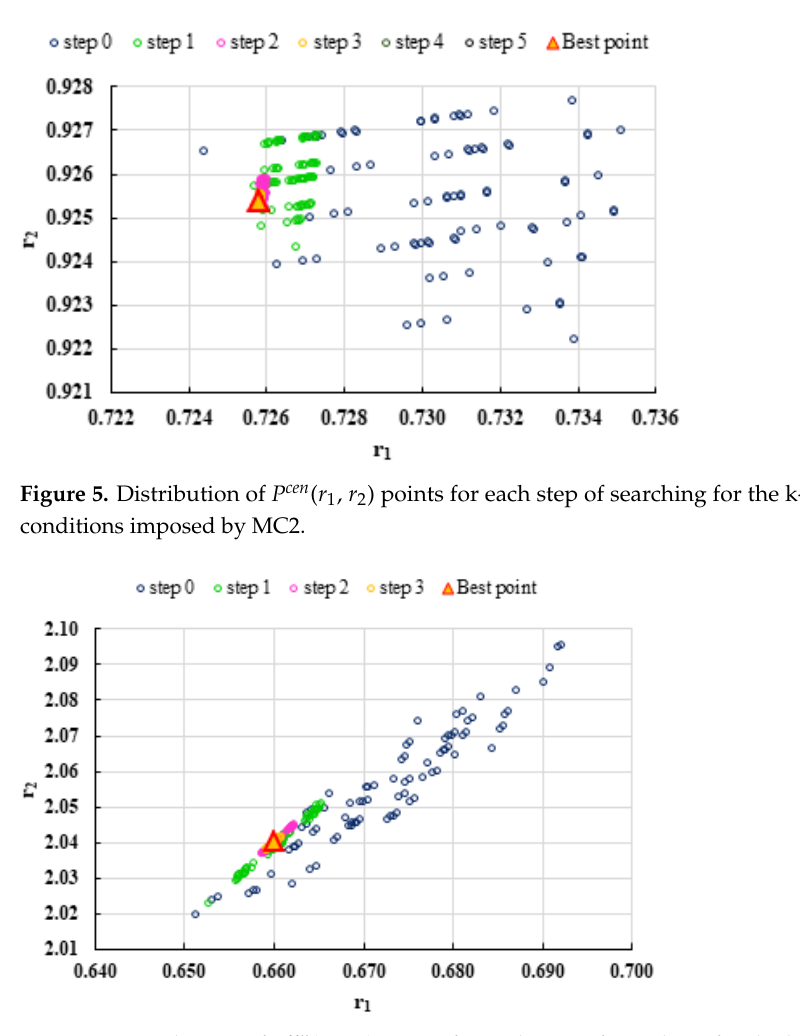
conditions imposed by MC1.